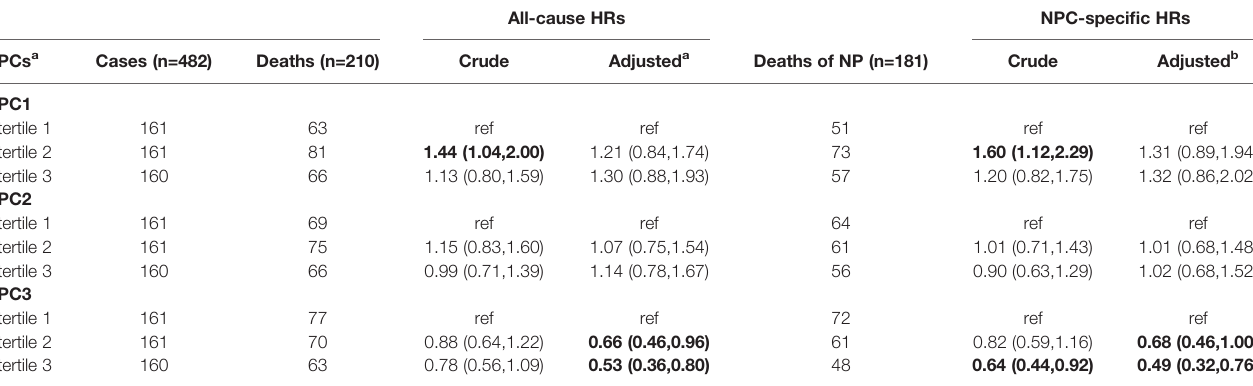
TABLE 3 | Hazard ratios (HRs) for mortality of NPC cases in relation to tertiled PCs from RPCA, Cox regression